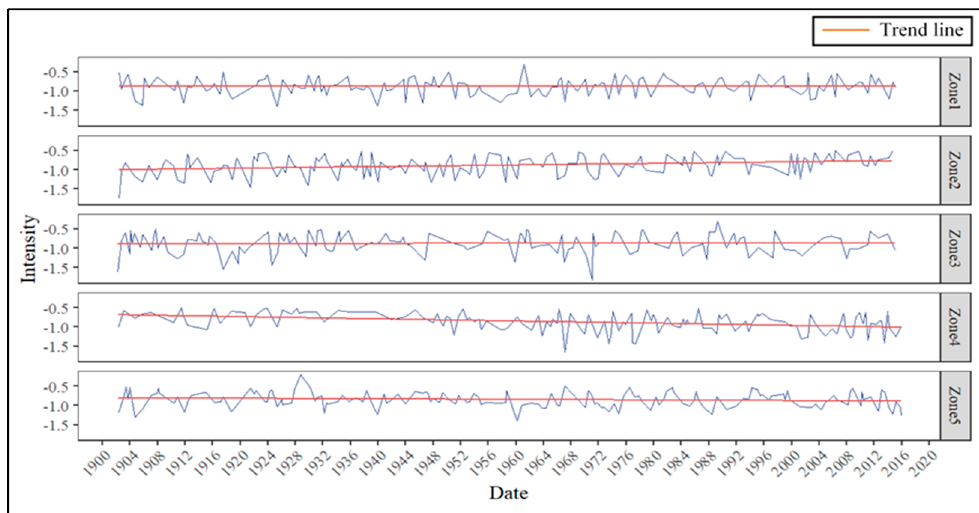
Figure 16. Drought severities for each zone.